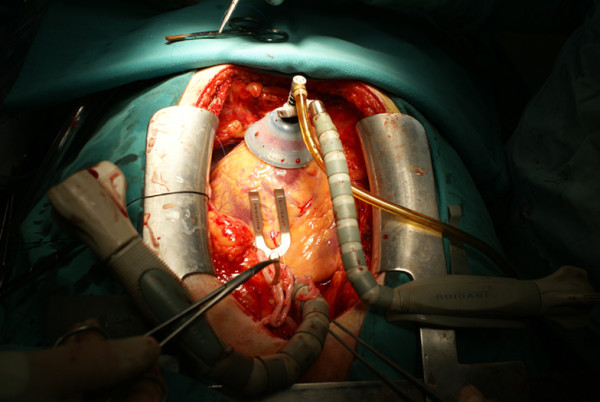
A combined use of an apical vacuum positioning device and a heart stabilization device.